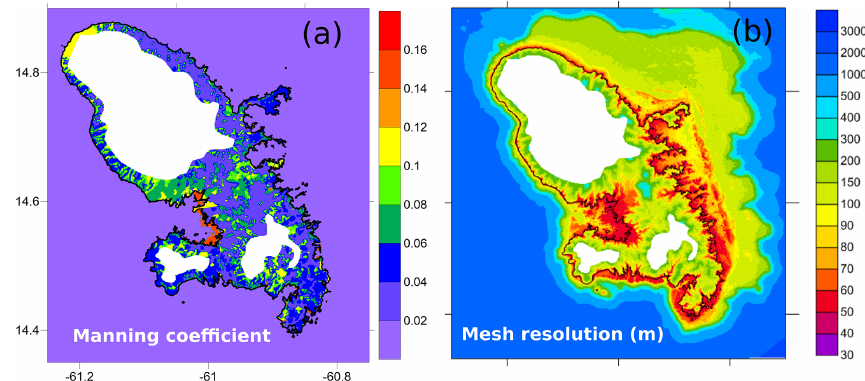
Figure 4. (a) Spatial variation of the Manning coefficient n , based on land cover data (European Union, 2006). (b) Spatial variation of the mesh resolution in the vicinity of Martinique. Table 1. Maximum storm surges (in meters) predicted by the model for the 13 worst case scenarios at four different locations: Fort-de-France tide gauge, airport, Le Robert tide gauge, and Le Vauclin. The distance of the hurricane track from Fort-de-France is also given. (S) or (N) refers to a storm passing south or north of Fort-de-France respectively. The maximum values obtained for each location are shown in